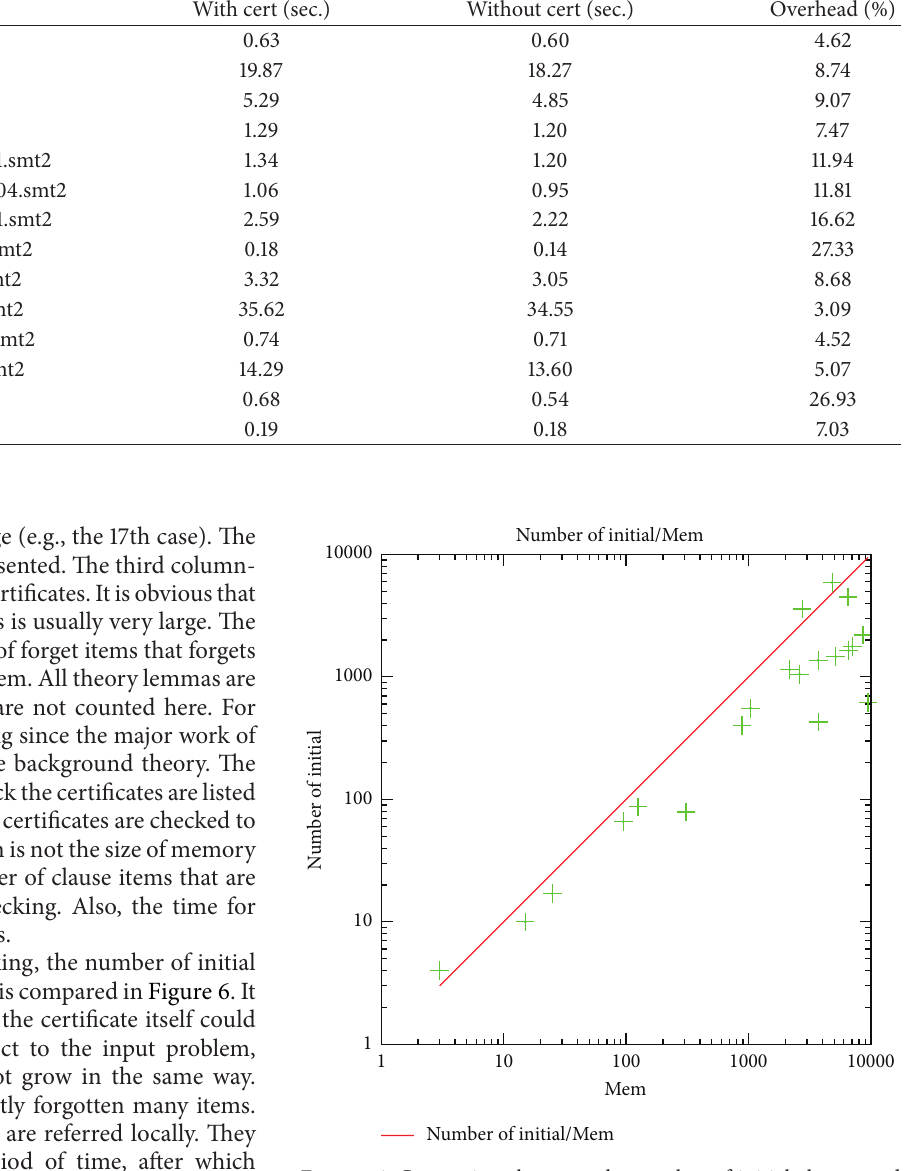
Figure 6: Comparison between the number of initial clauses and memory